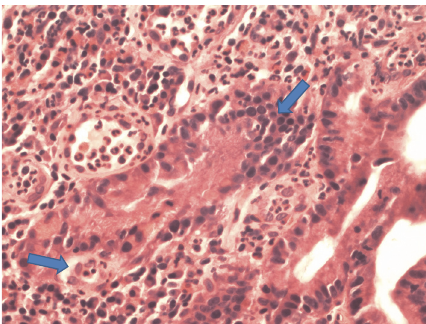
Figure 5: Haematoxylin and eosin (H&E) stain of small bowel tissue sample at high power (400x magnification) demonstrating acute focal cryptitis evidenced by neutrophils within the glandular architecture (arrow), and expansion of the lamina propria by a diffuse neutrophilic infiltrate.